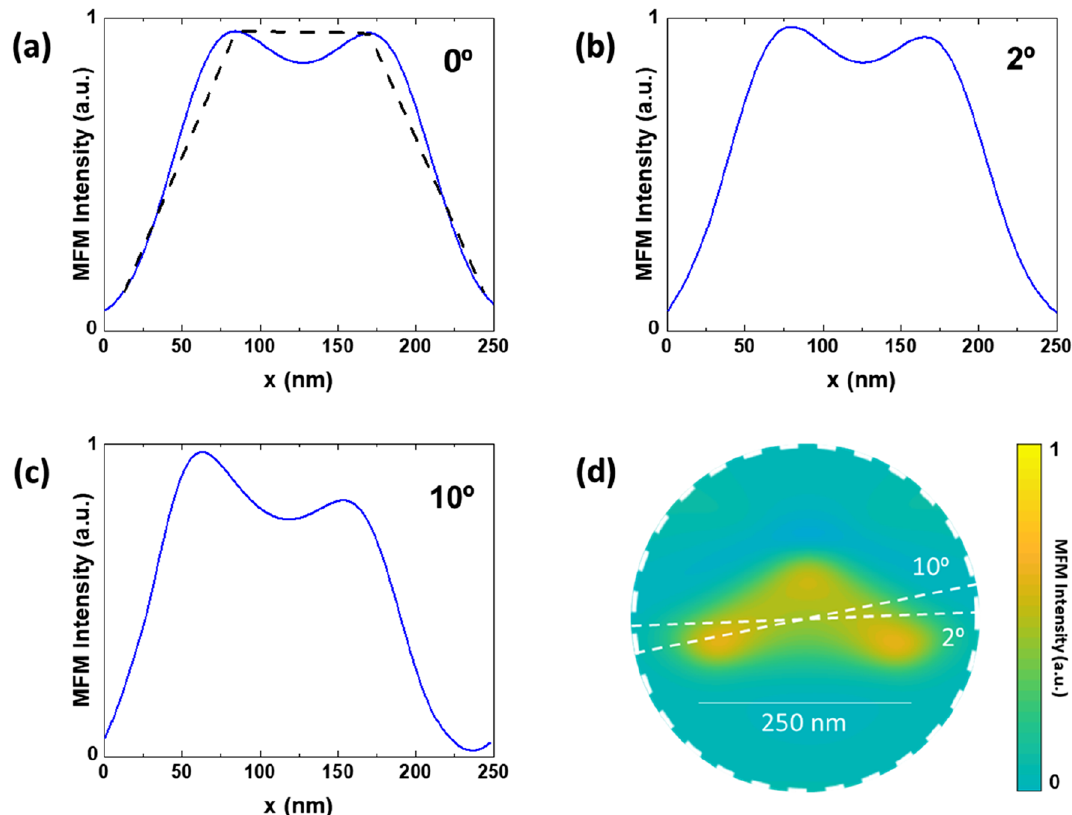
Figure 4. Simulated profiles of a single -1 magnetic charge potential well for different vortex trajectories, to monitor asymmetry changes as the vortex movement deviates from a perfectly symmetrical profile (0 deg) ( a ); ( b ) corresponding to 2 deg.; ( c ) corresponding to 10 deg.; ( d ) sketch of the asymmetric potential with two vortex trajectories